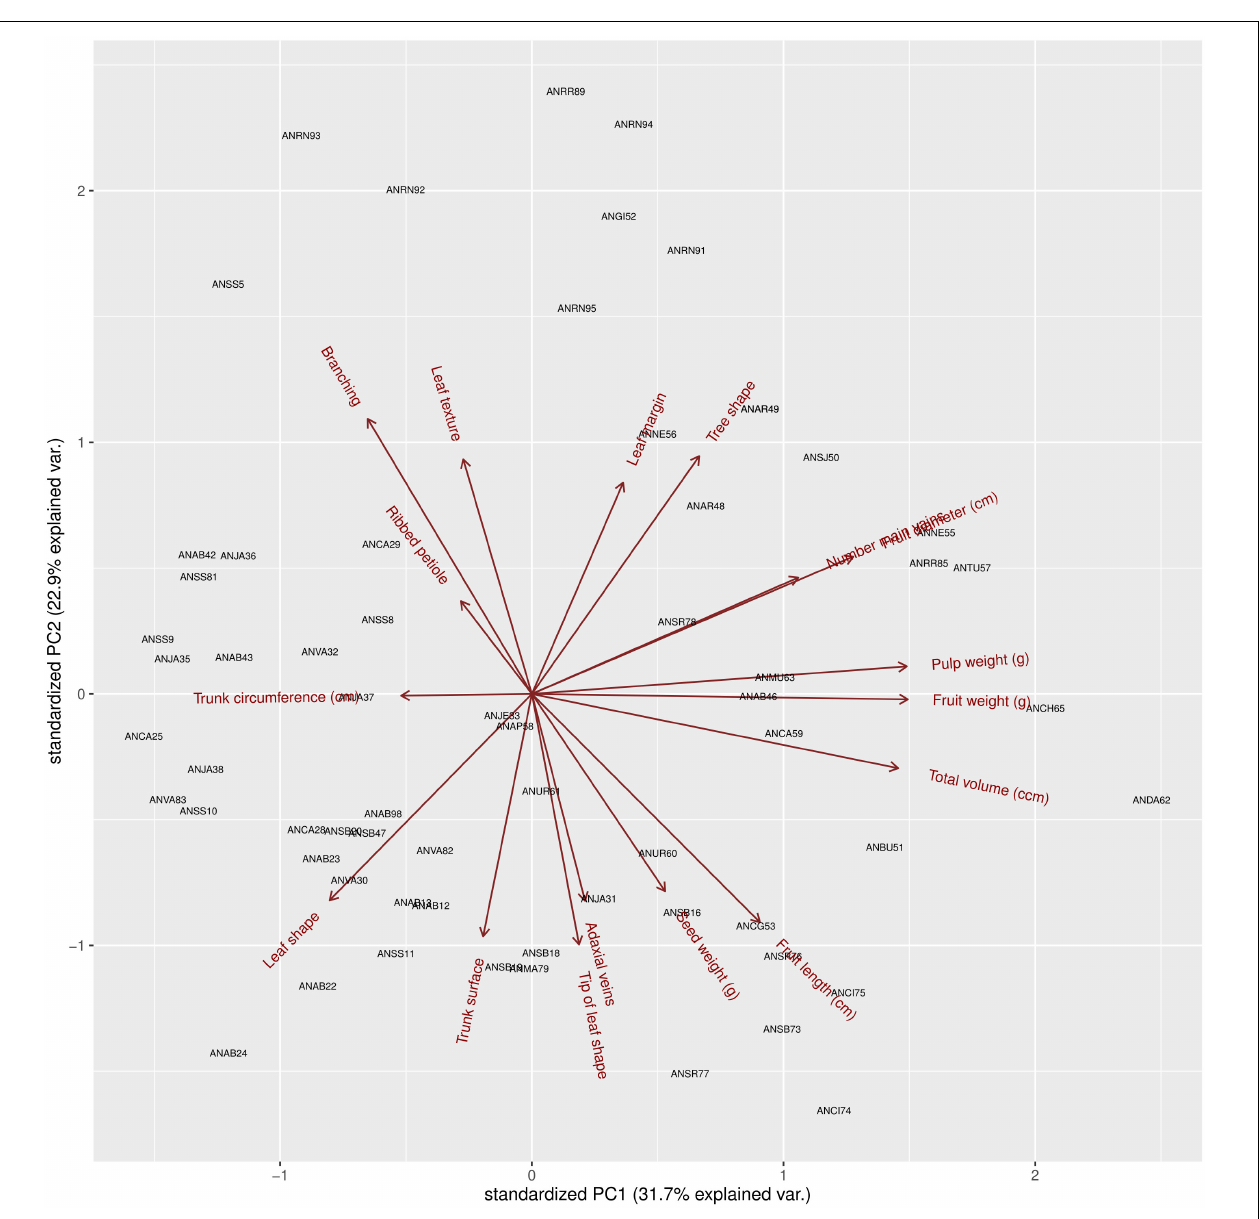
FIGURE 6 | Breeding values for traits (vectors in red) measured in avocado “criollo” “plus trees” (black codes) selected as seed donors for rootstocks of the cv. Hass. A match between the specific tree code and the arrow of the trait vector indicates an additive genetic superiority (a.k.a., breeding value) of that particular tree for the specific trait. Opposing vectors speak for negative genetic correlations, which may limit simultaneous selection for both traits in the same direction, as opposed to orthogonal vectors that suggest traits are free from genetic correlations.